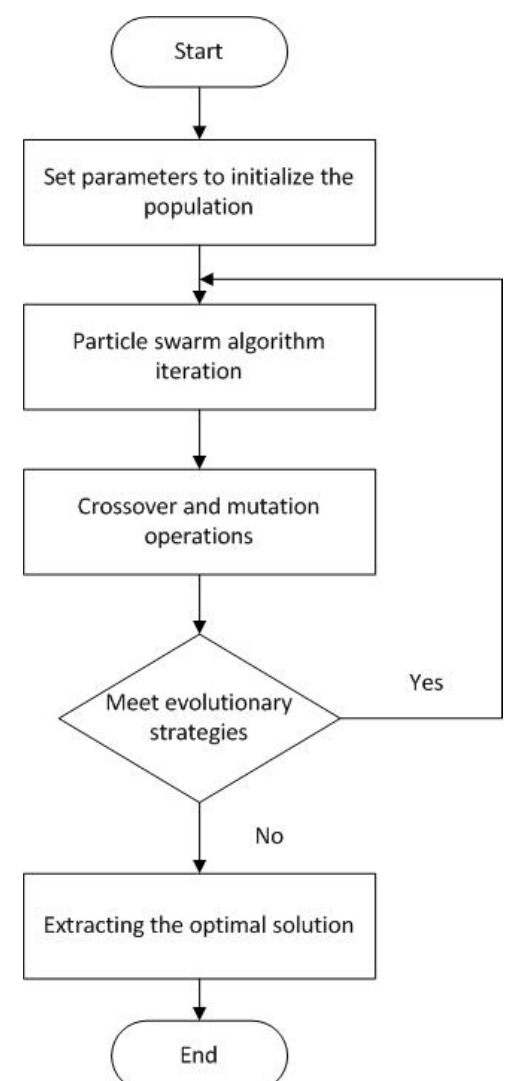
Figure 1. Flow chart of particle swarm optimization-genetic algorithm (PSO-GA) hybrid algorithm.